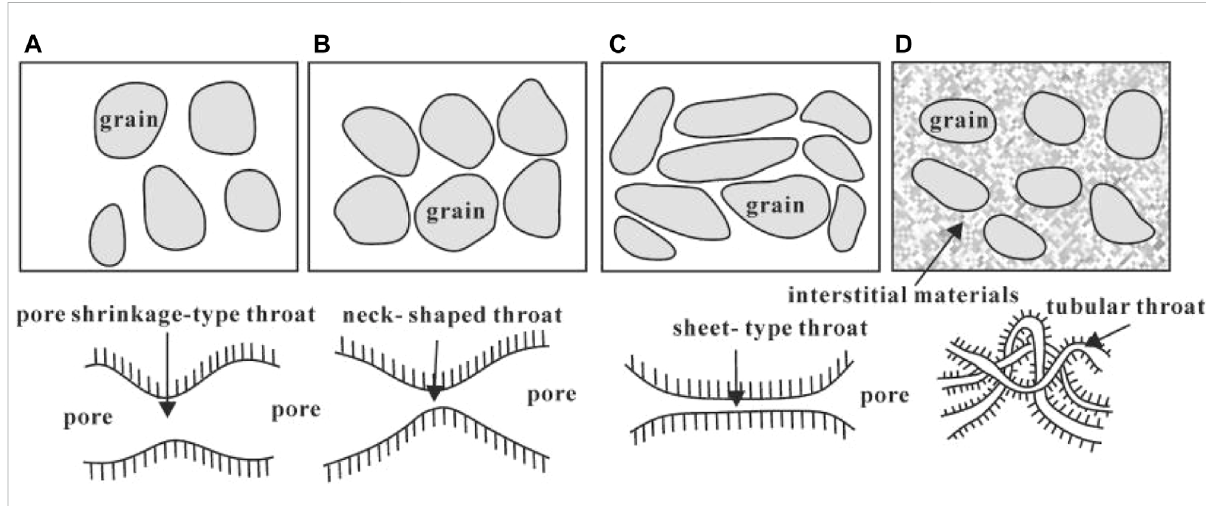
FIGURE 3 Majorporetypes insandstone reservoirs(Zhong etal.,2021). (A) pore-shrinkage-typethroat; (B) neck-shapedthroat; (C) sheet-type throat; (D) tubular